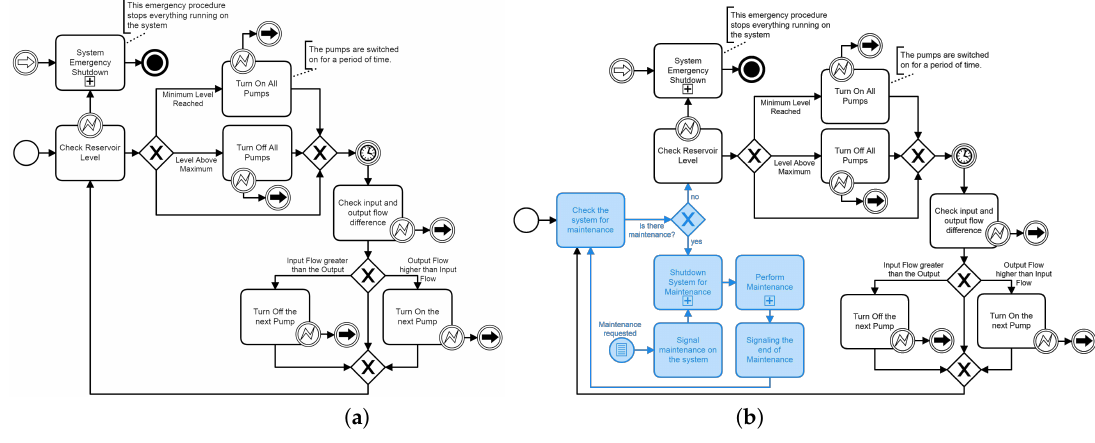
Figure 15. The impact of modification in the declarative model: ( a ) before; ( b ) after.